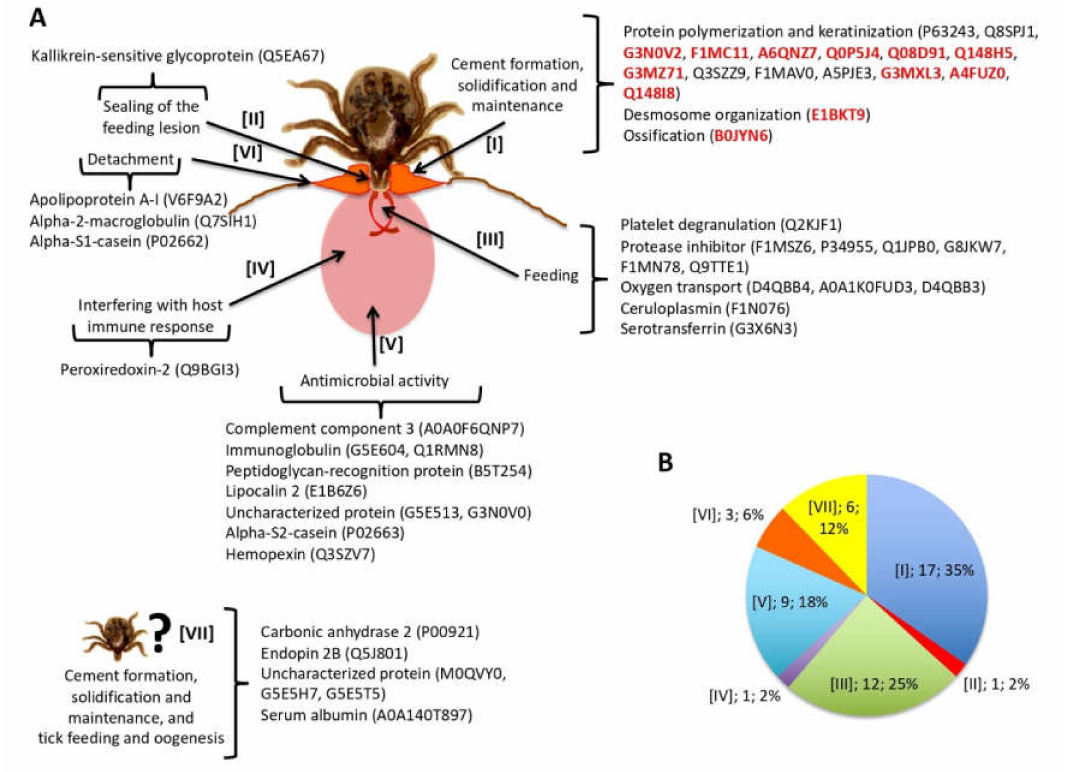
Figure 5. Host-derived cementome proteins. ( A ) Host proteins identified in both sialome and cementome (Table S2) were found in all of the processes previously proposed to be present in the tick cementome. Proteins selected for further analyses are highlighted in red. ( B ) Protein representation (process, number of proteins, and percentage) in the different processes previously proposed to be present in the tick